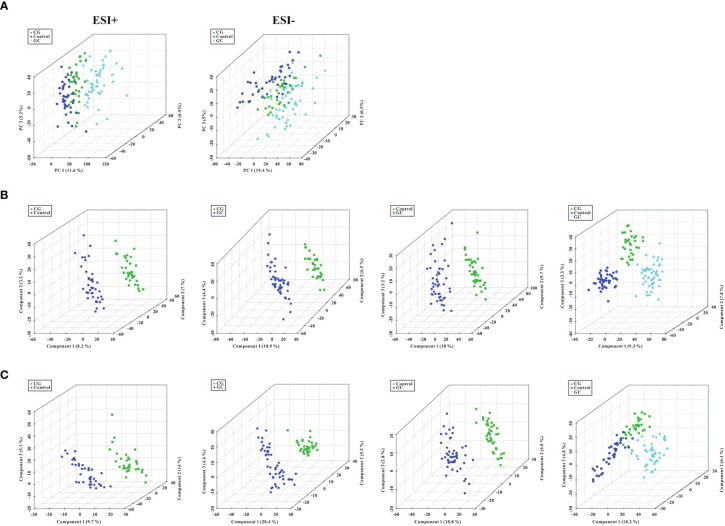
Score plots of PCA model and the first three latent components of PLS- DA model. (A) Three-dimensional score plot of the PCA model of all samples in the ESI+ and ESI− ion modes. (B, C) Score plots for the first three latent components of the PLS-DA model for CG vs Control, CG vs GC, GC vs Control, and CG plus GC vs Control in the ESI+ and ESI− ion modes, respectively. Healthy volunteers, control, CG, chronic gastritis; GC, gastric cancer.